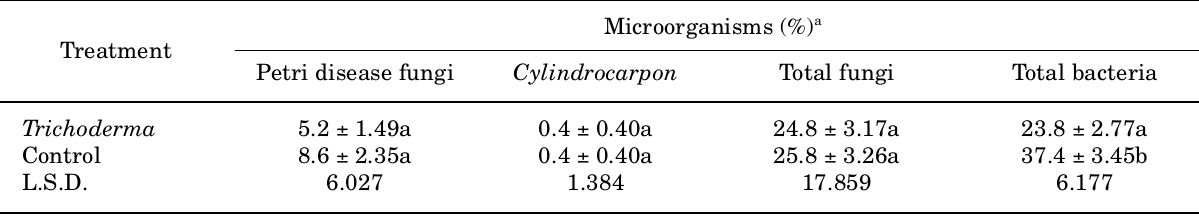
Table 3. Mean percentages a of Petri disease fungi ( Phaeomoniella chlamydospora and Phaeoacremonium spp.), Cylin- docarpon spp., total fungi and total bacteria present in rootstocks of Trichoderma treated and standard treated (control) nursery grapevines.